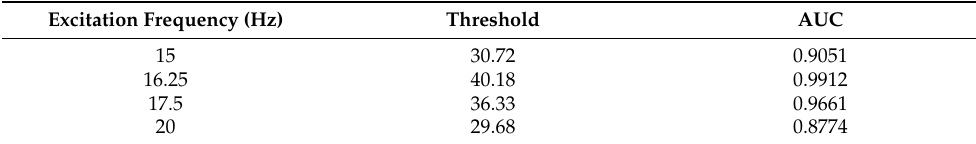
Table 3. Optimal threshold values for each excitation frequency and its related AUC.